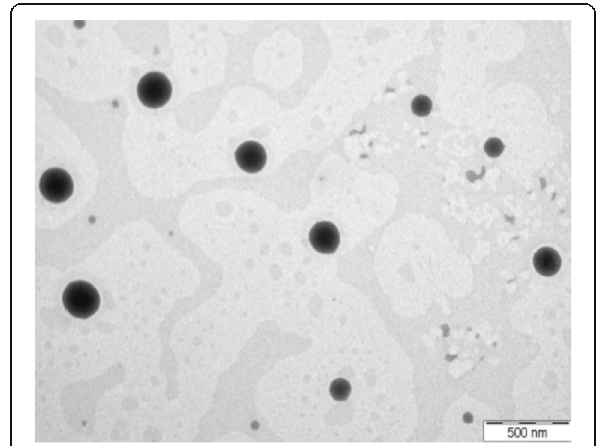
Fig. 10 TEM image of VER-9 before lyophilization